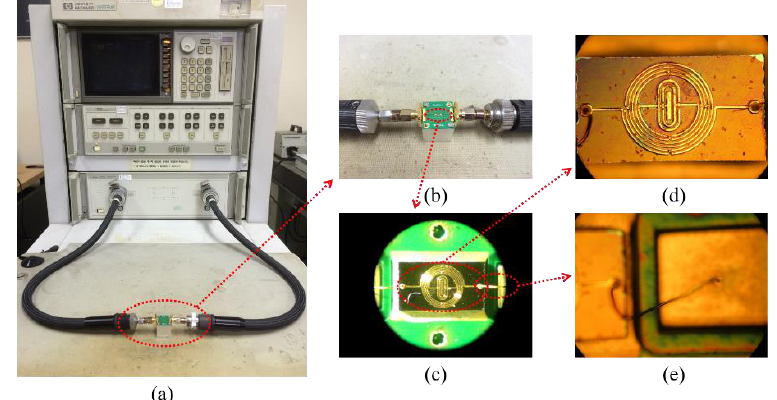
Figure 6. S-parameter measurement setup for the proposed BPF. ( a ) Bandpass filter-vector network analyzer (VNA) cable connection; ( b ) a magnified view of the BPF and its input/output ports; ( c ) 50 × -magnified top view of the BPF wire bonded to the printed circuit board (PCB); ( d ) a microscopic view of the fabricated onboard chip; ( e ) a microscopic view showing the BPF input-/output-port wire bond to the input/output pad.